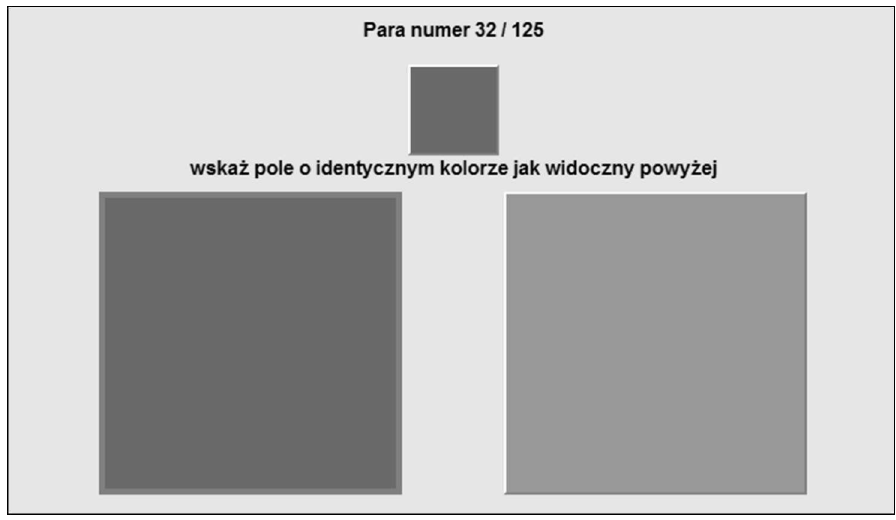
Figure 3. Interface of the model game (source: own